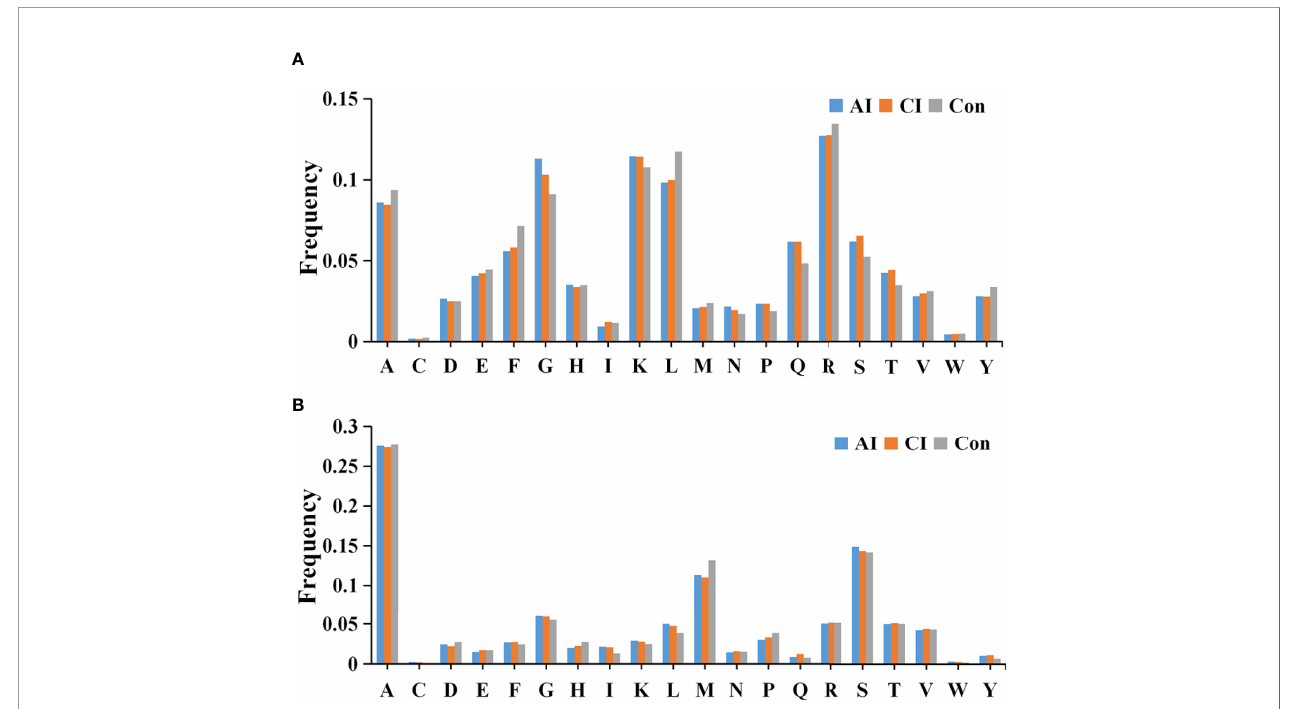
FIGURE 4 | Frequency of the cleavage sites in the identi fi ed peptides. Cleavage speci fi city analysis of N-terminal peptide residue (A) or C-terminal peptide residue (B) .